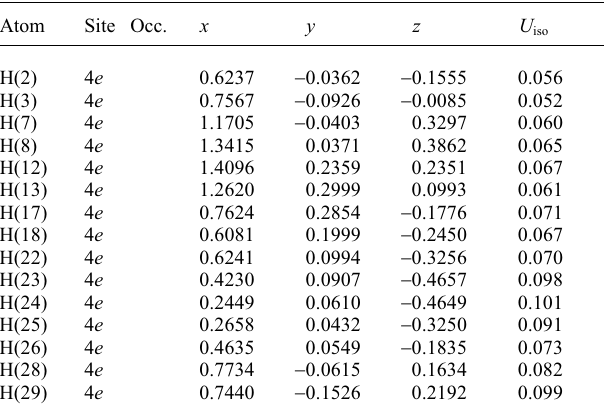
Table 2. Atomic coordinates and displacement parameters (in Å 2 ) . Atom Site Occ. U